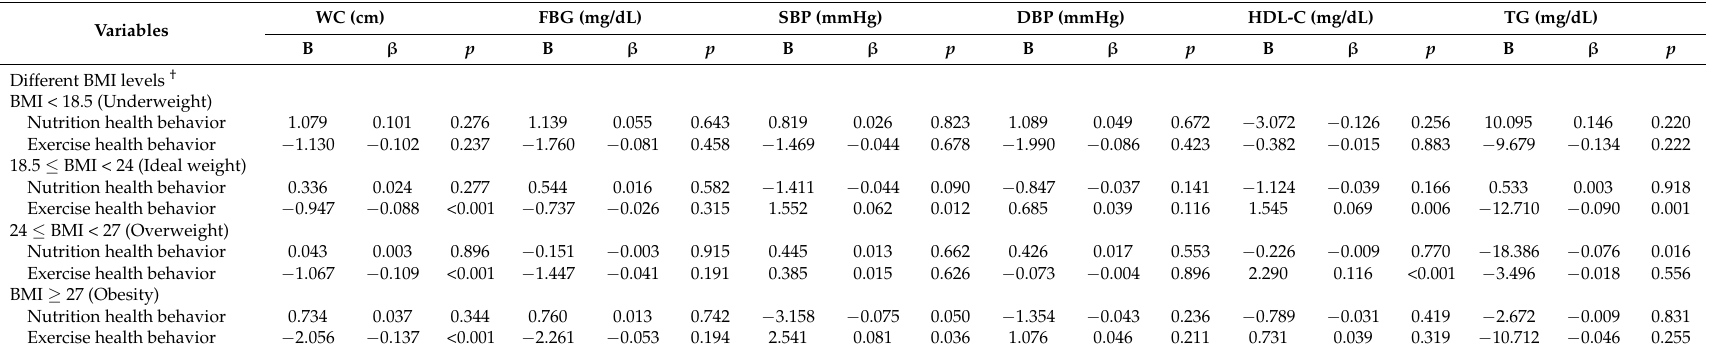
Table 4. Linear regression models predicting metabolic risk factors in relation to nutrition and exercise health behavior according to different BMI levels ‡ .